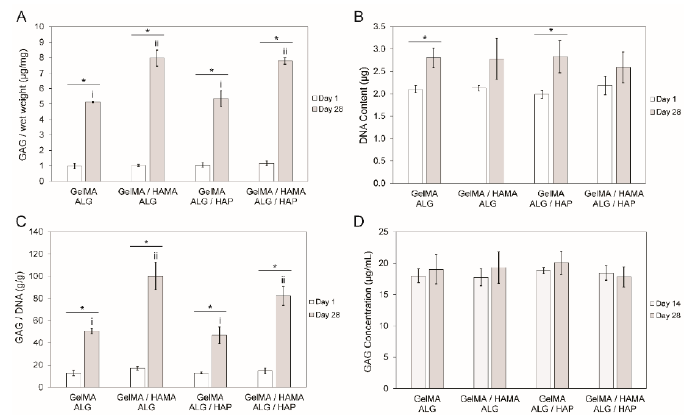
Figure 6. DNA and GAG content in constructs over the culture period. ( A ): comparison of day 1 and day 28 results of GAG content ( µ g) per gel wet weight (mg); ( B ): DNA content ( µ g) per gel; ( C ): GAG